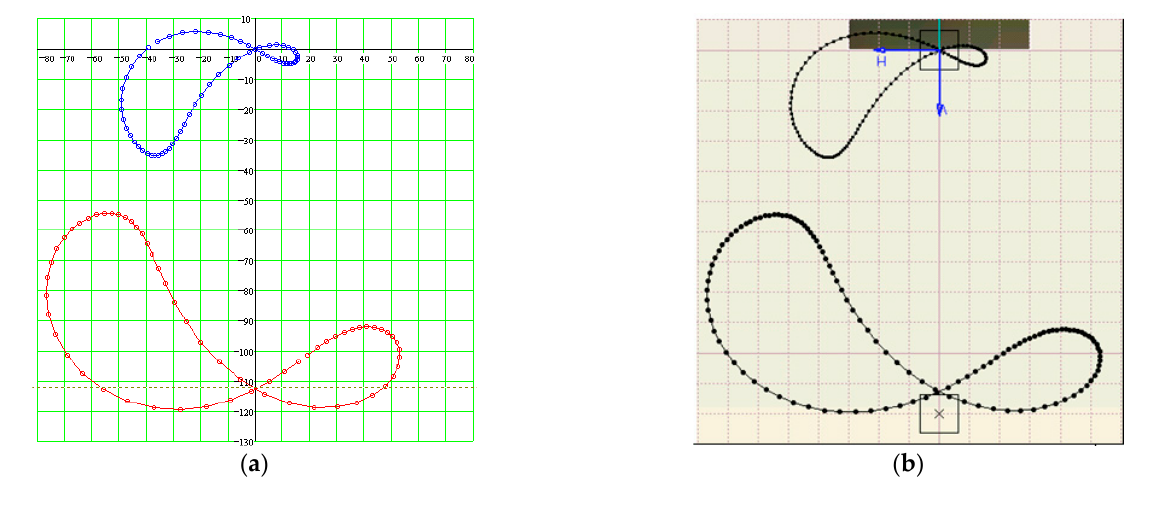
Figure 25. Quantitative assessment of the tracks of the balls’ centers in the symmetry plane of the channel: ( a ) present analytical relations plotted in Mathcad; ( b ) kinematics simulation in CATIA.